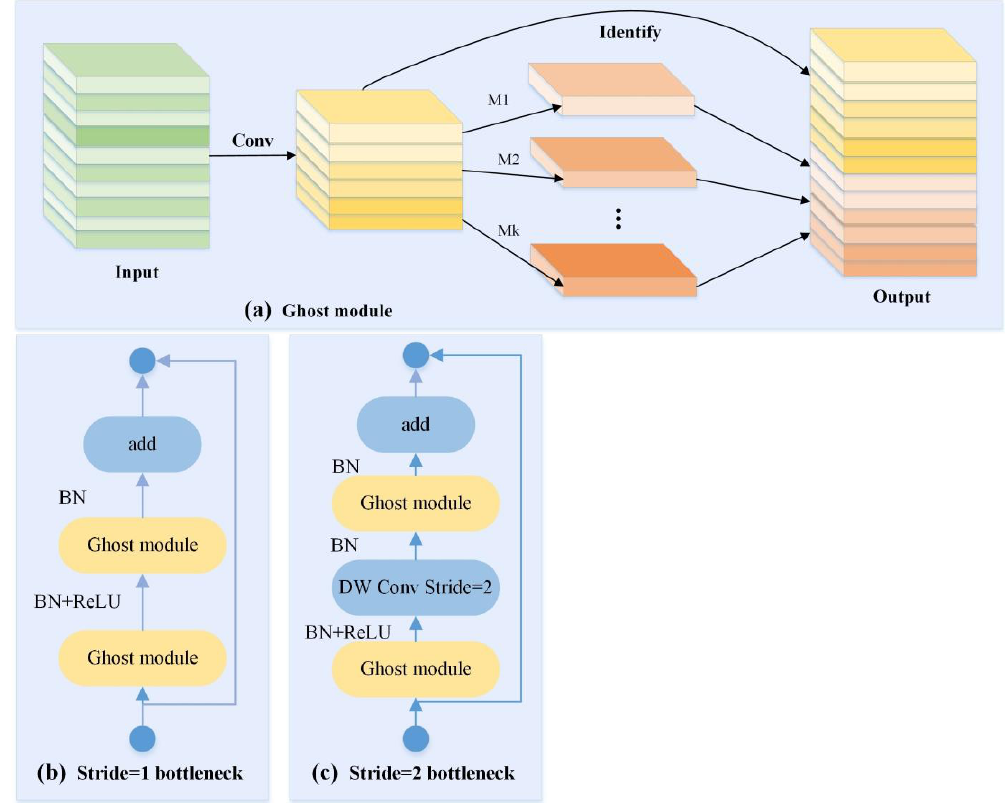
Figure 6. Diagram of the Ghost module ( a ) and the structure of the Ghost Bottleneck ( b , c ).